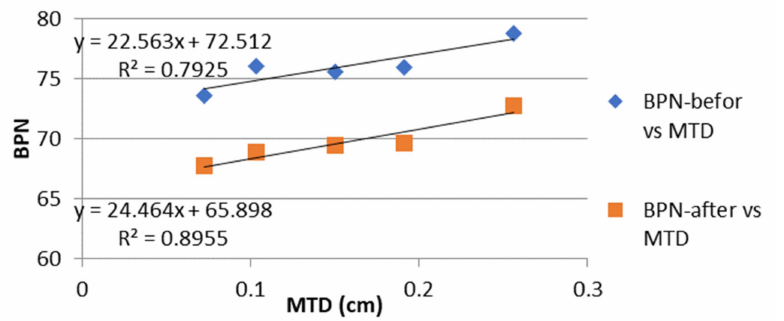
Figure 18. The relationship between BPN and MTD in both before and after abrasion test on RCCP